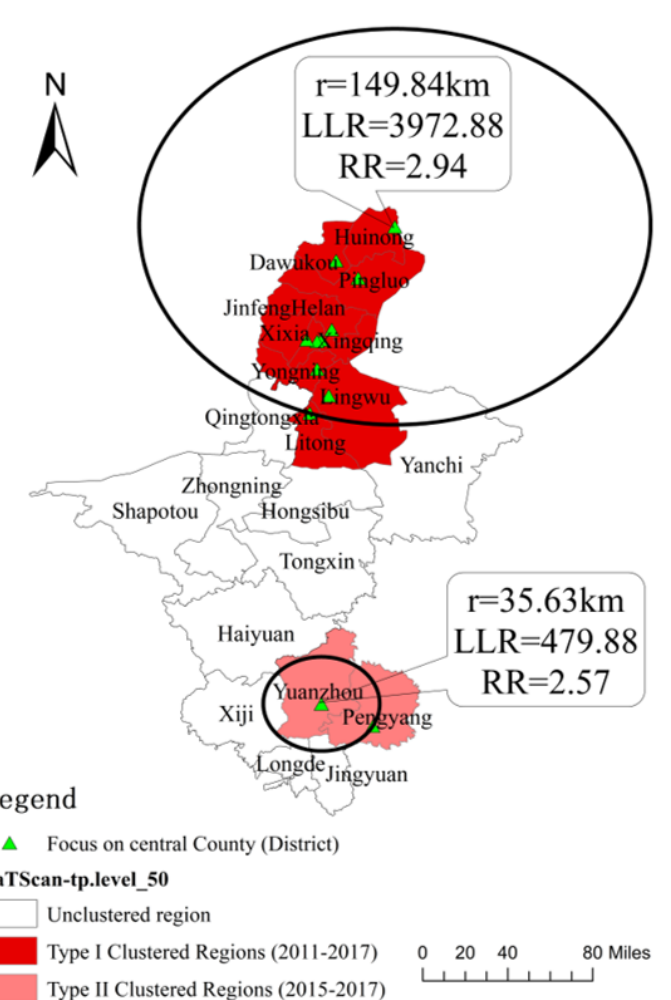
Figure 2. Spatial and temporal scan distribution of syphilis incidence in Ningxia, 2004–2017. Note: r is the radio of high-risk spatiotemporal clustering, LLR is the log likelihood ratio and RR is the relative risk of clustering area.